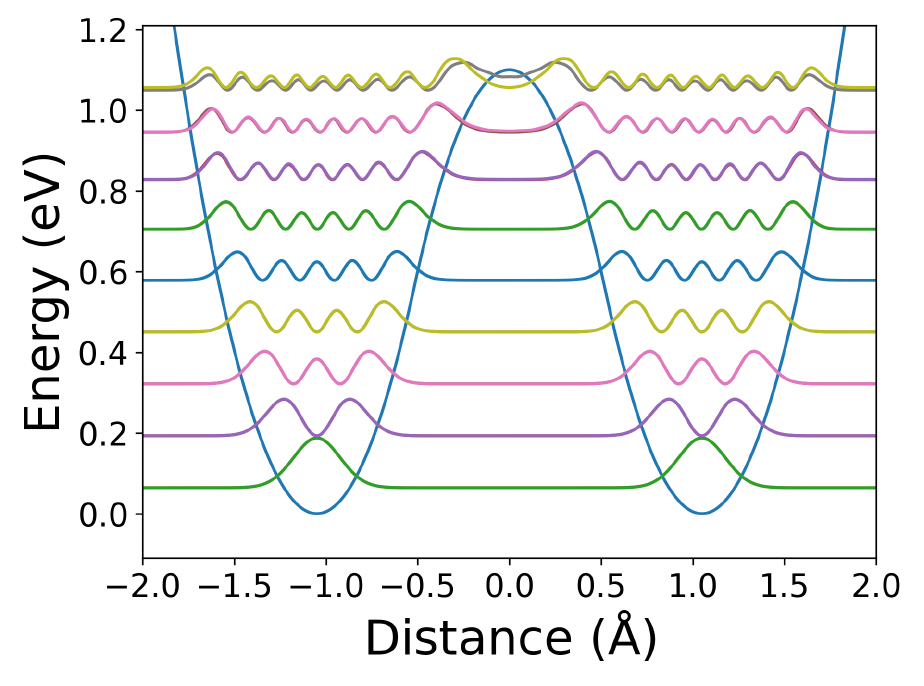
Figure 3. Hydrogen probability densities for the int-int diffusion hop. Probability densities are shifted upward by their eigenvalue and colored for the sake of clarity. The double well results in a splitting of all energy levels, which is on a scale smaller scale than shown in the plot for lower